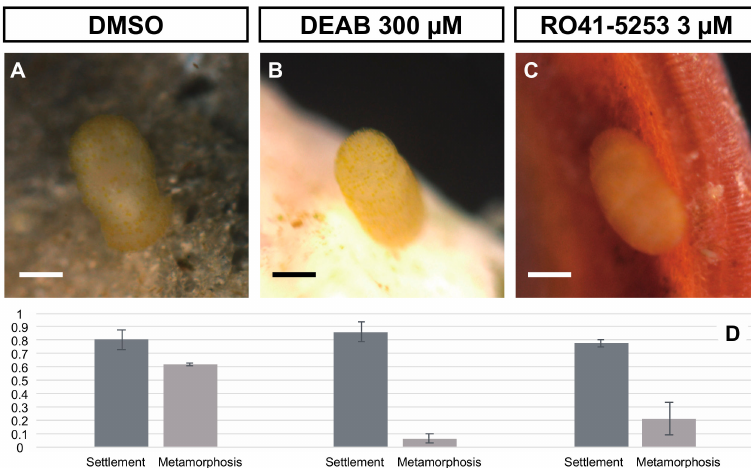
Figure 4. E ff ects of DEAB or RO treatment on settlement and metamorphosis. We treated doliolaria larvae with DMSO (control), DEAB 300 µ M or RO 3 µ M and examined the e ff ects on settlement and metamorphosis. ( A – C ) show the settled larvae on substrates (natural sands from their adult habitat) in DMSO, DEAB and RO treatments. The ratio of settlement and metamorphosis is shown in ( D ) (dark gray; settlement ratio, light gray; metamorphosis ratio). Scale bars: 125 µ